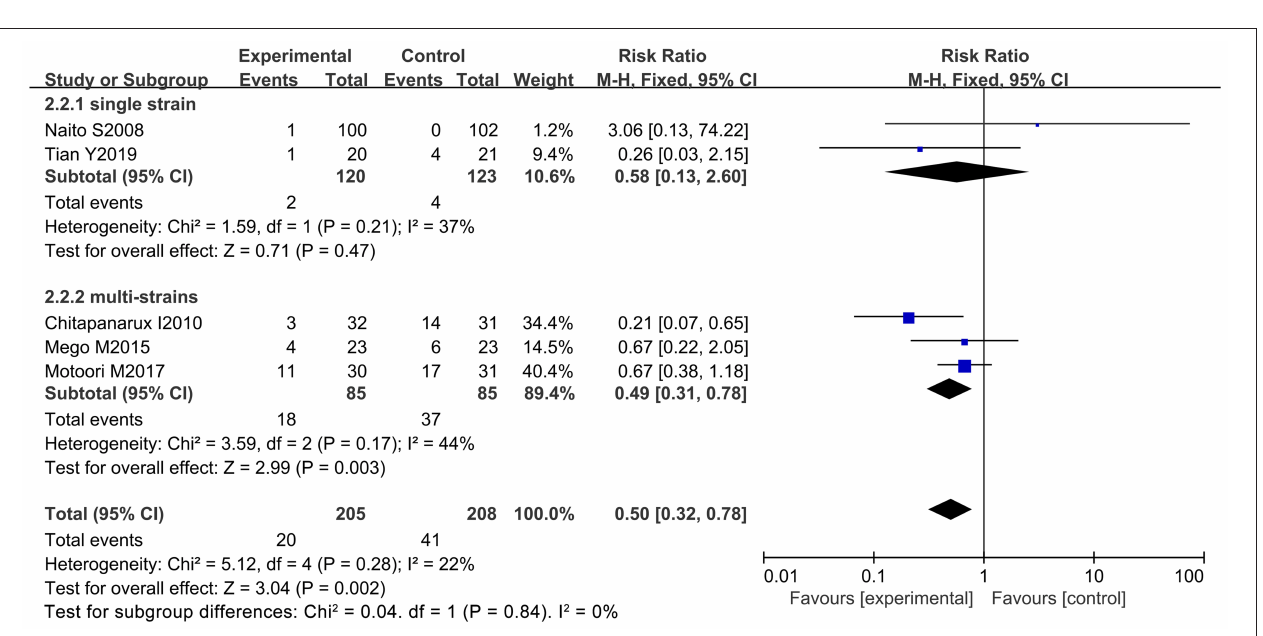
FIGURE 11 | Subgroup analysis of the efficacy of bacterial number on the incidence of severe diarrhea in cancer patients.